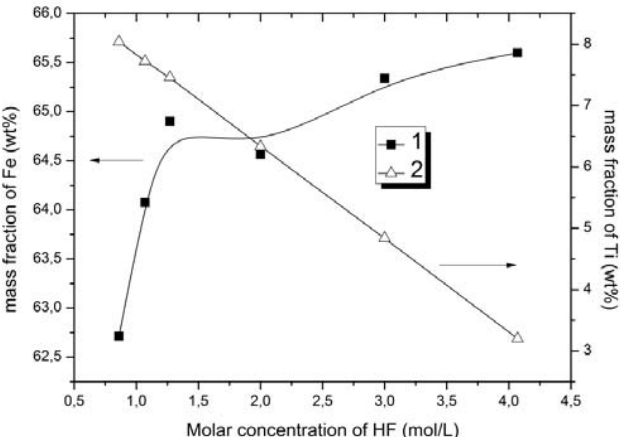
Figure 6. Iron and titanium content in solid phase vs. concentration of hydrofluoric acid for a fixed ammonium fluoride concentration of 0.42 mol/L. (1)—Mass fraction of Fe in solid phase (wt %); (2)—Mass fraction of Ti in solid phase (wt %).